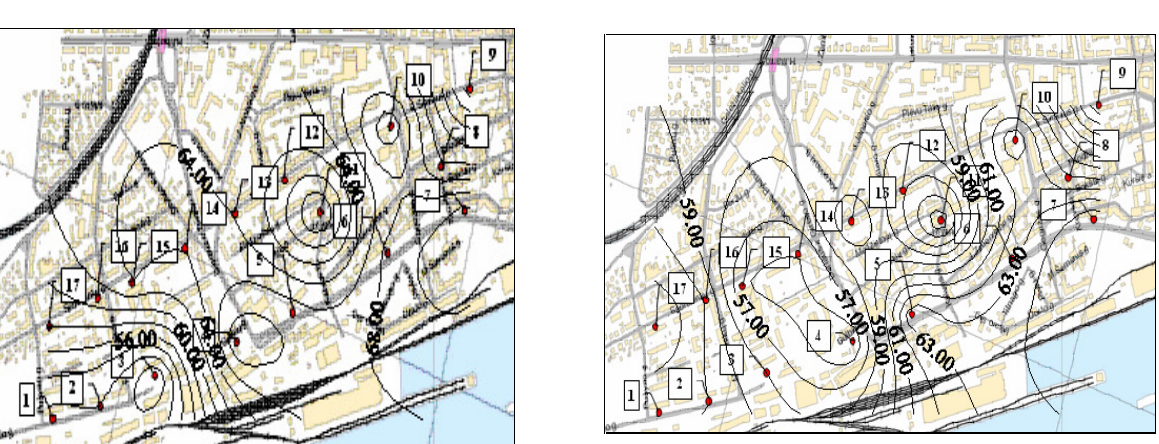
Fig. 7. Noise spread in the northern part of Klaipėda city in the evening in summer